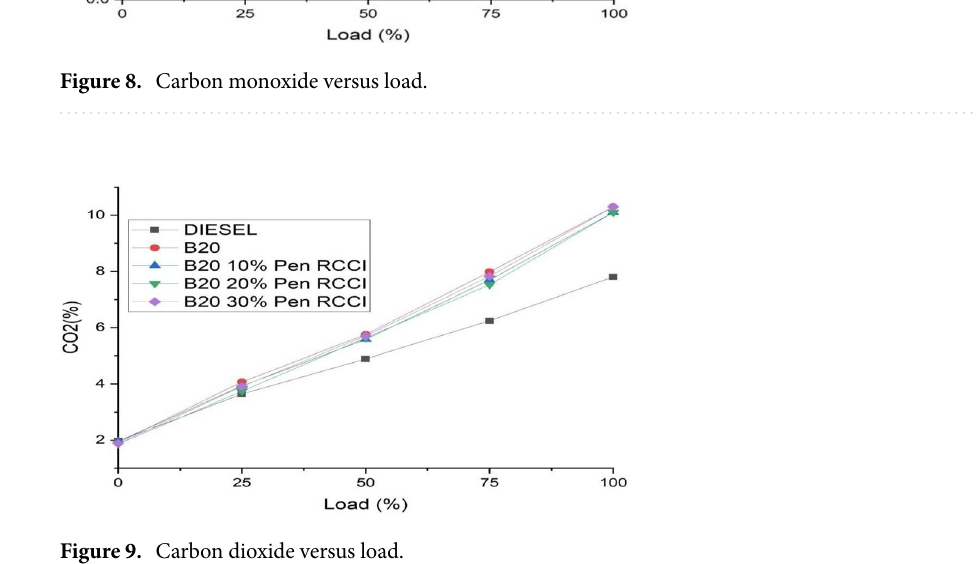
Figure 9. Carbon dioxide versus